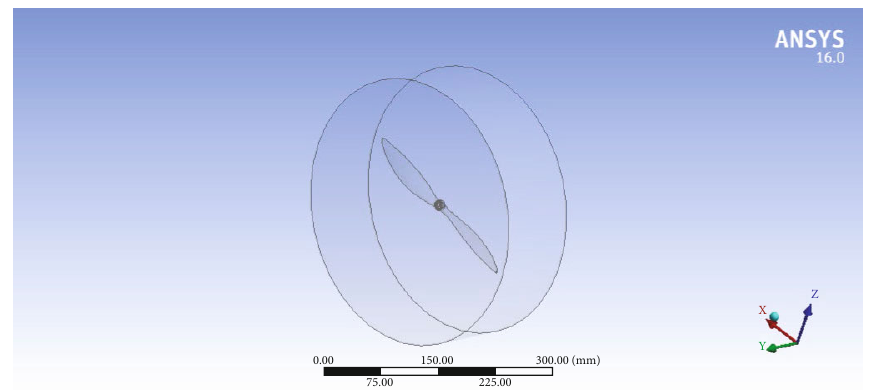
Figure 11: Rotation domain of Design-1.